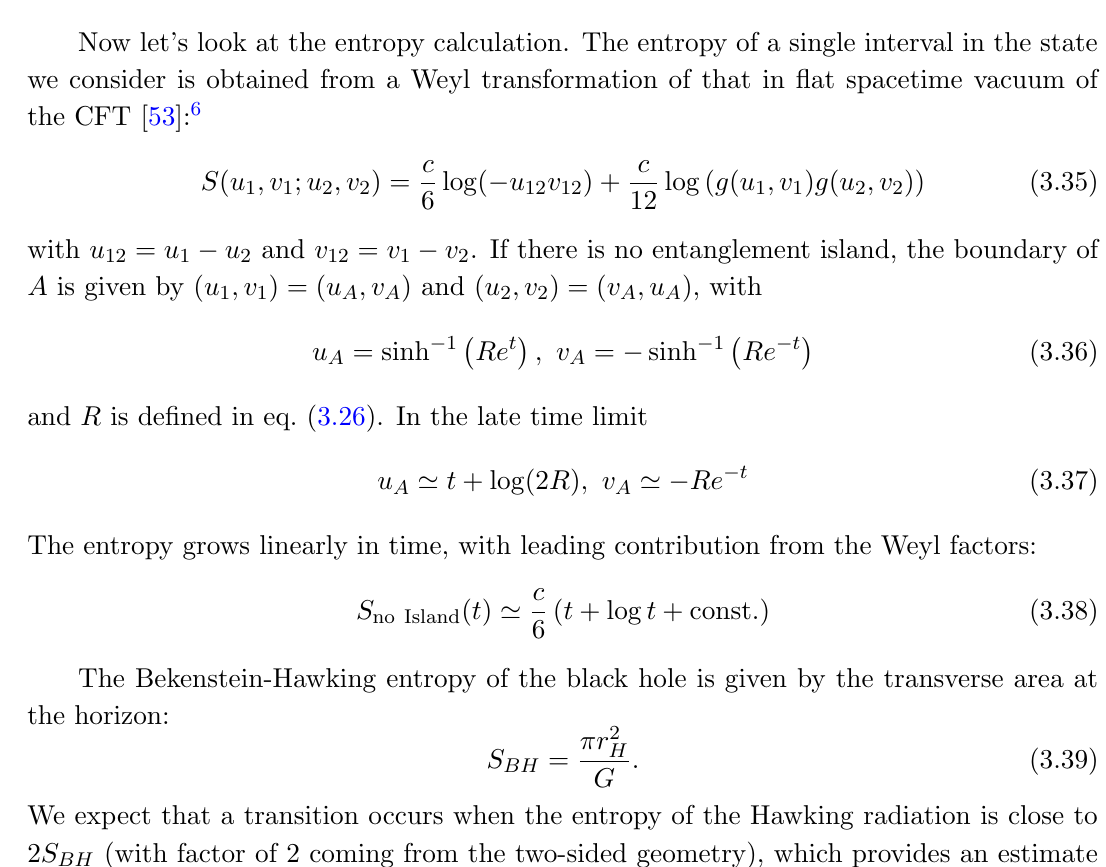
Figure 12. (a) Energy current density as a function of Schwarzchild time. (b) Total energy (cid:13)ux at late time, which is an integration of the energy current density for t 2 [0 ; + 1 ), as a function of radius r